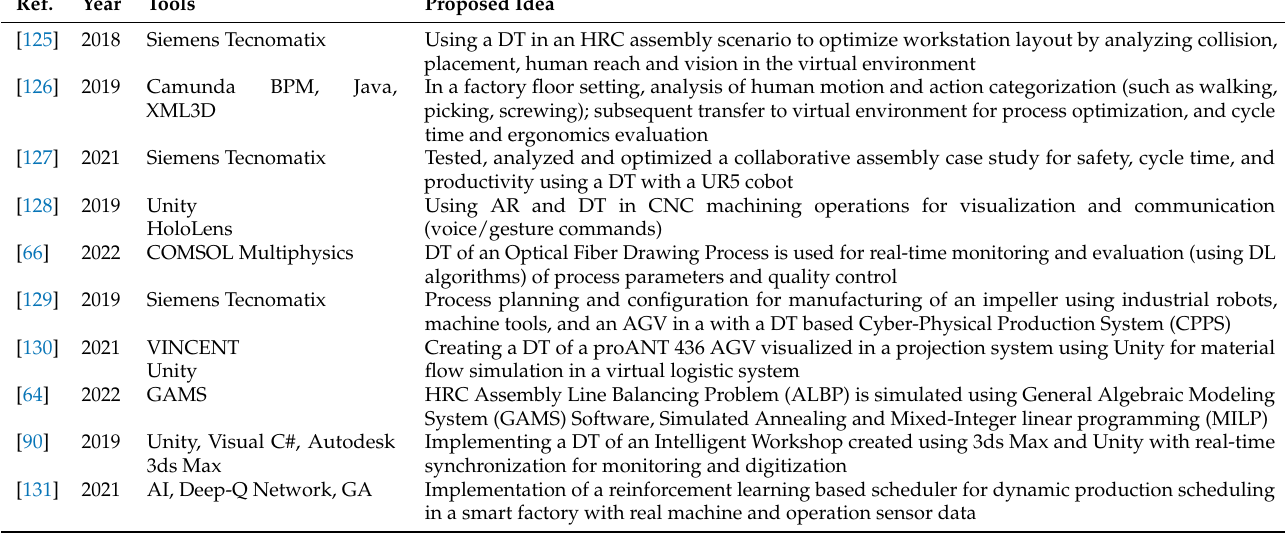
Table 6. Applications in Design, Validation, and